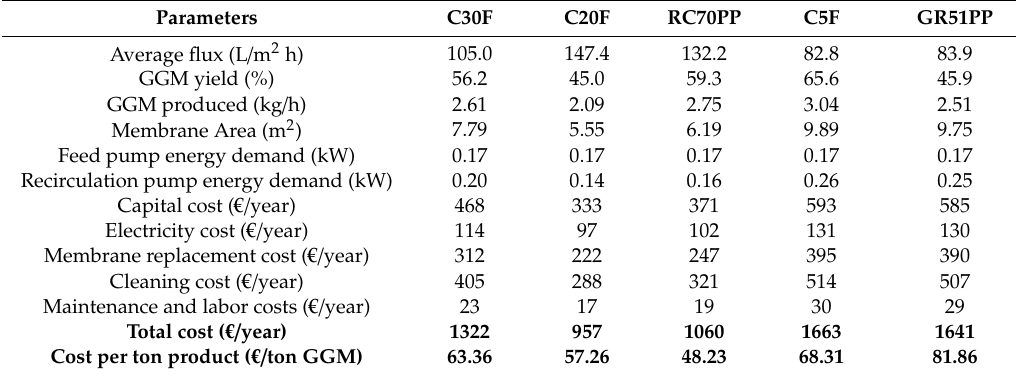
Table 3. Cost estimations for galactoglucomannan (GGM) recovery using the hydrophobic and hydrophilic